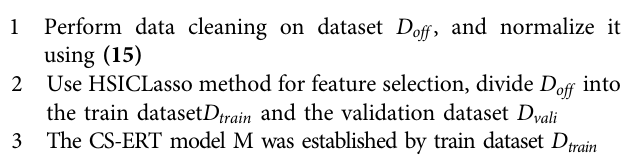
Algorithm 2 Of fl ine implementation of the CS-ERT fault detection method.